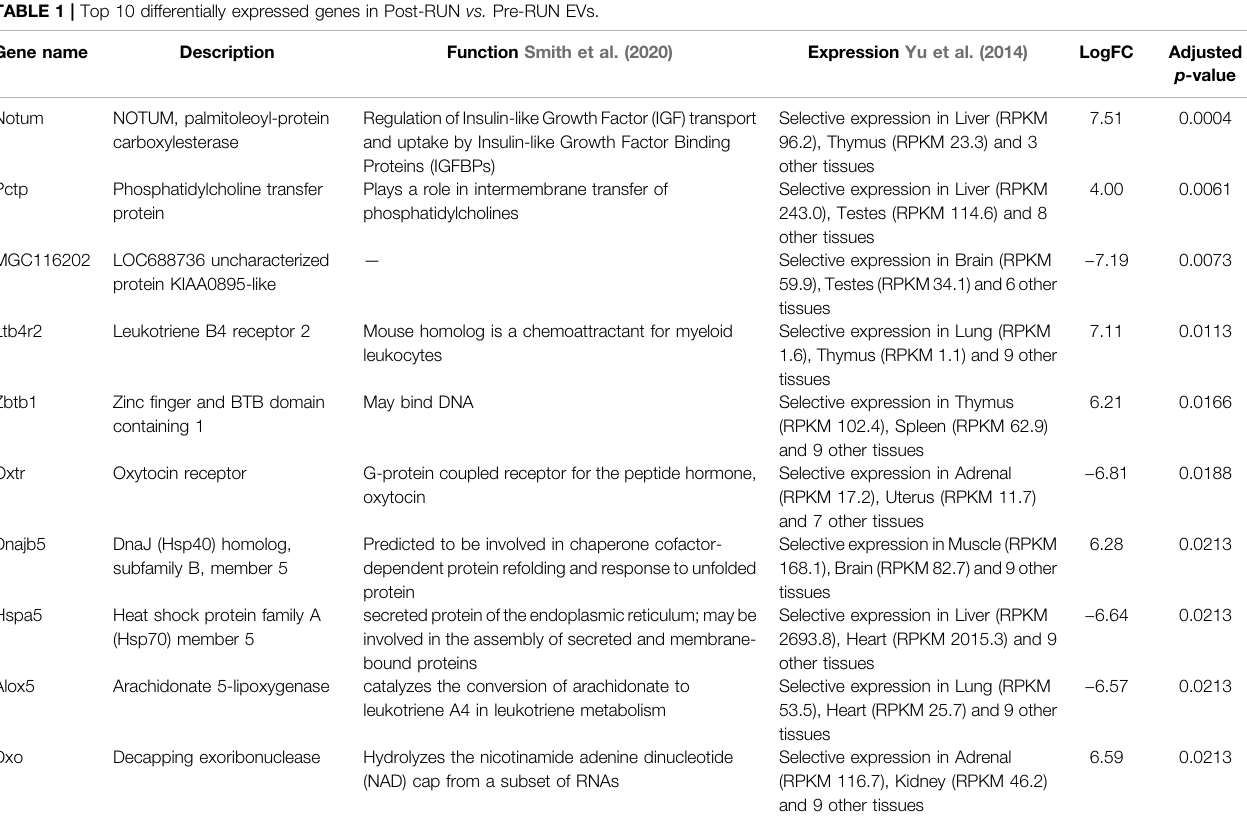
TABLE 1 | Top 10 differentially expressed genes in Post-RUN vs. Pre-RUN